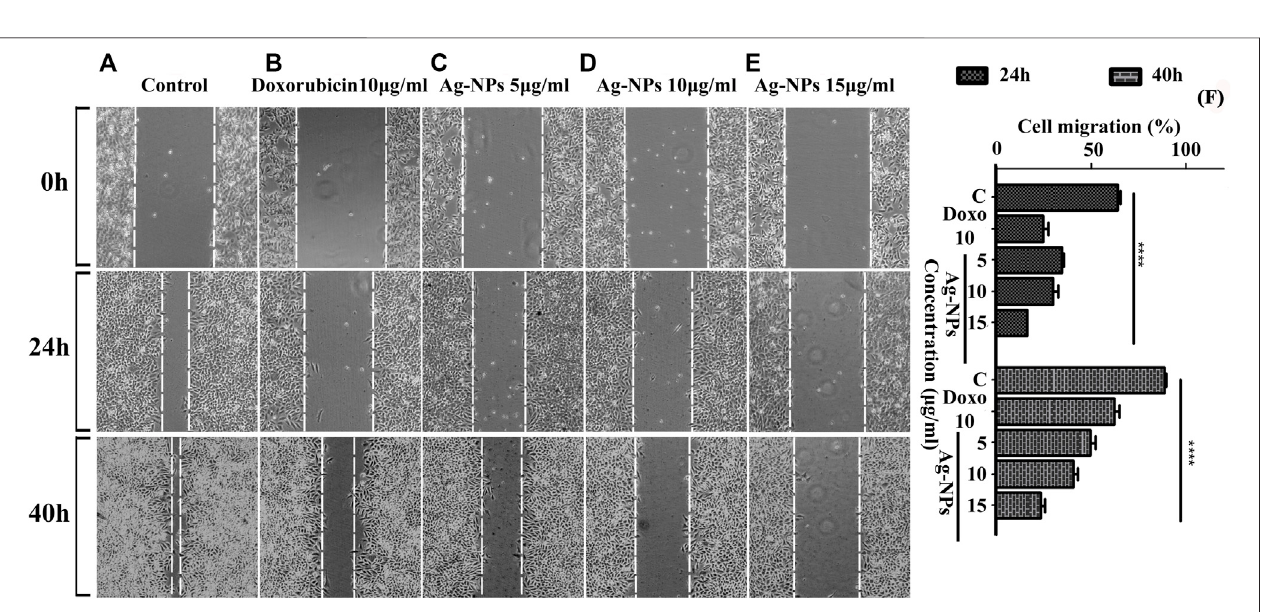
Frontiers in Pharmacology |